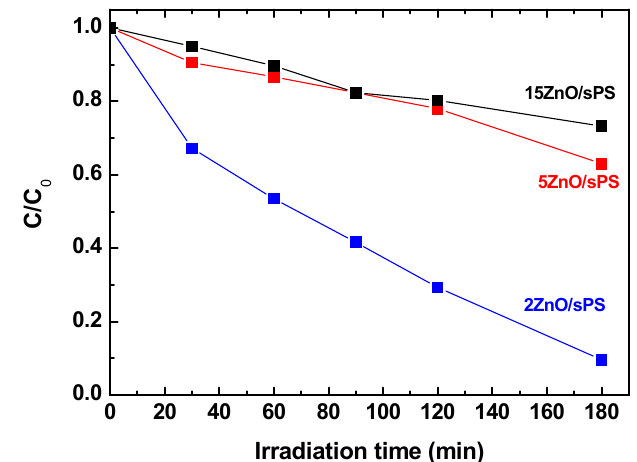
Figure 7. Phenol concentration in aqueous solutions treated with the ZnO / s-PS δ -form aerogels with ZnO content from 2 wt% (i.e., 0.08 g / L of ZnO) to 15 wt% (i.e., 0.6 g / L of ZnO).